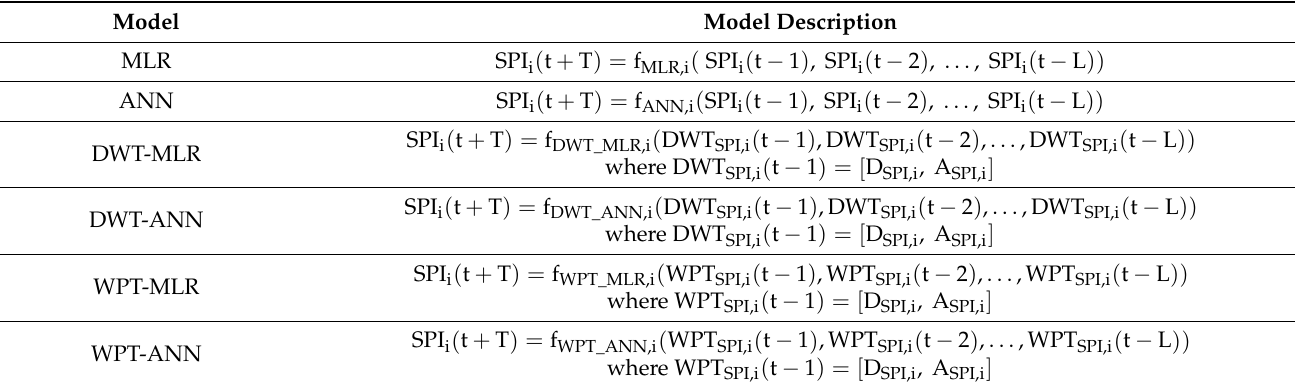
Table 2. Description of different types of